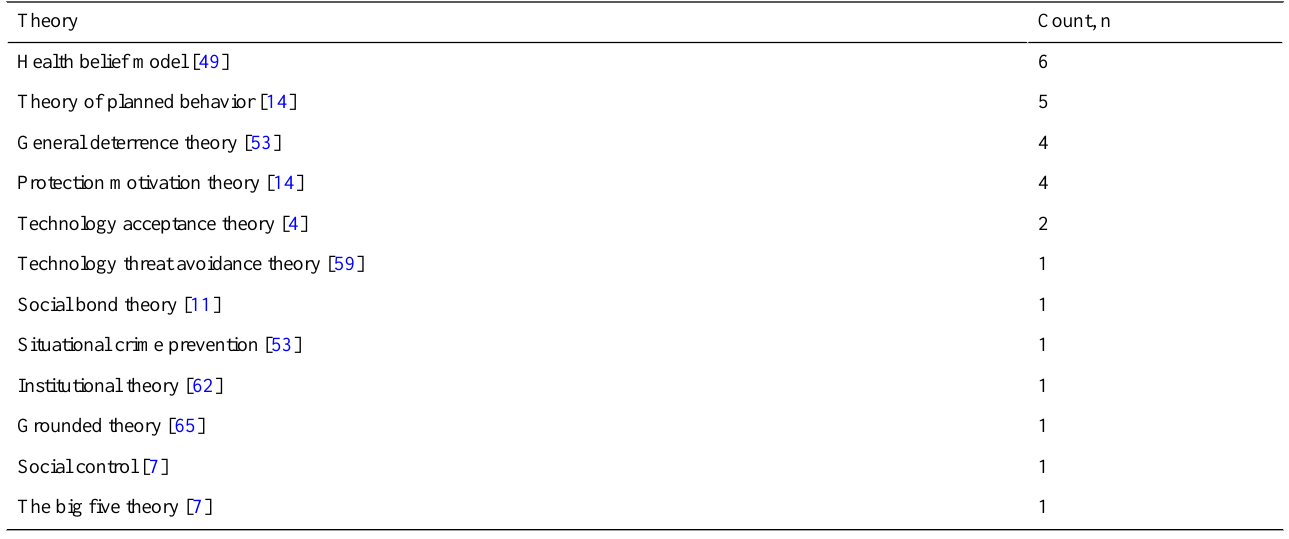
Table 2. Psychological, social, and cultural theories.